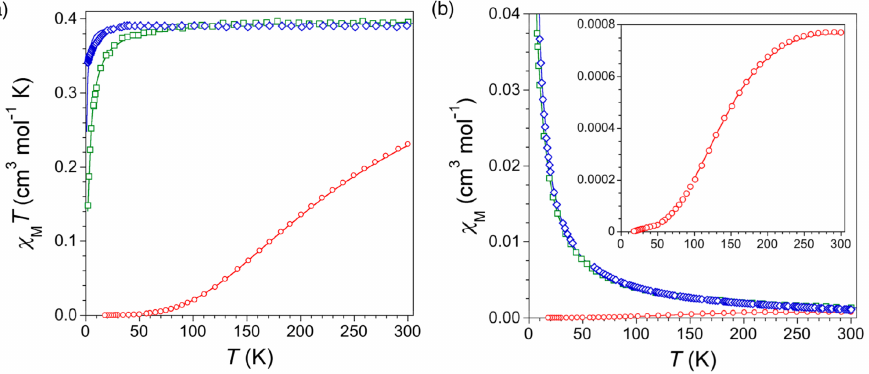
Figure 6. Temperature dependence of χ M T ( a ) and χ M ( b ) of 1 ( 3 ( ♦ ). The inset in ( b ) aims to show how the maximum of χ M of 1 ( The solid lines are the best-fit curves (see